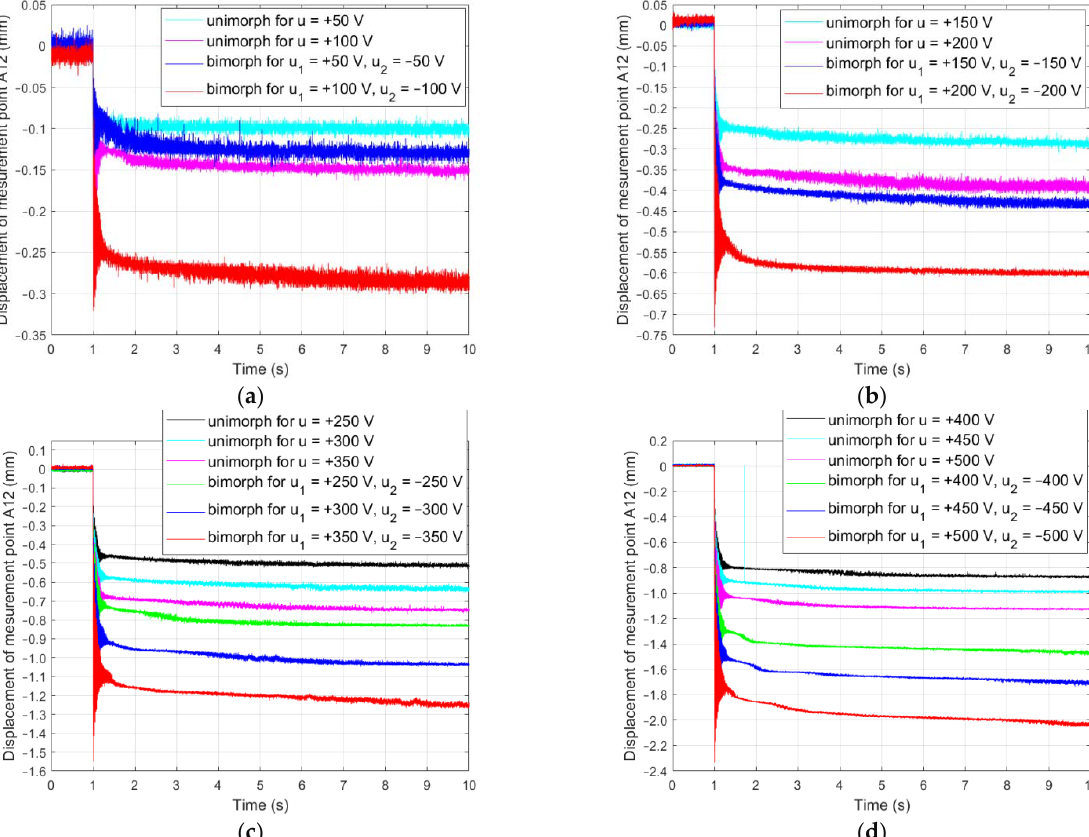
Figure 10. Displacements of measurement point A12 in unimorph and bimorph: ( a ) for control signals 50 V and 100 V; ( b ) for control signals 150 V and 200 V; ( c ) for control signals 250 V, 300 V and 350 V; ( d ) for control signals 400 V, 450 V and 500